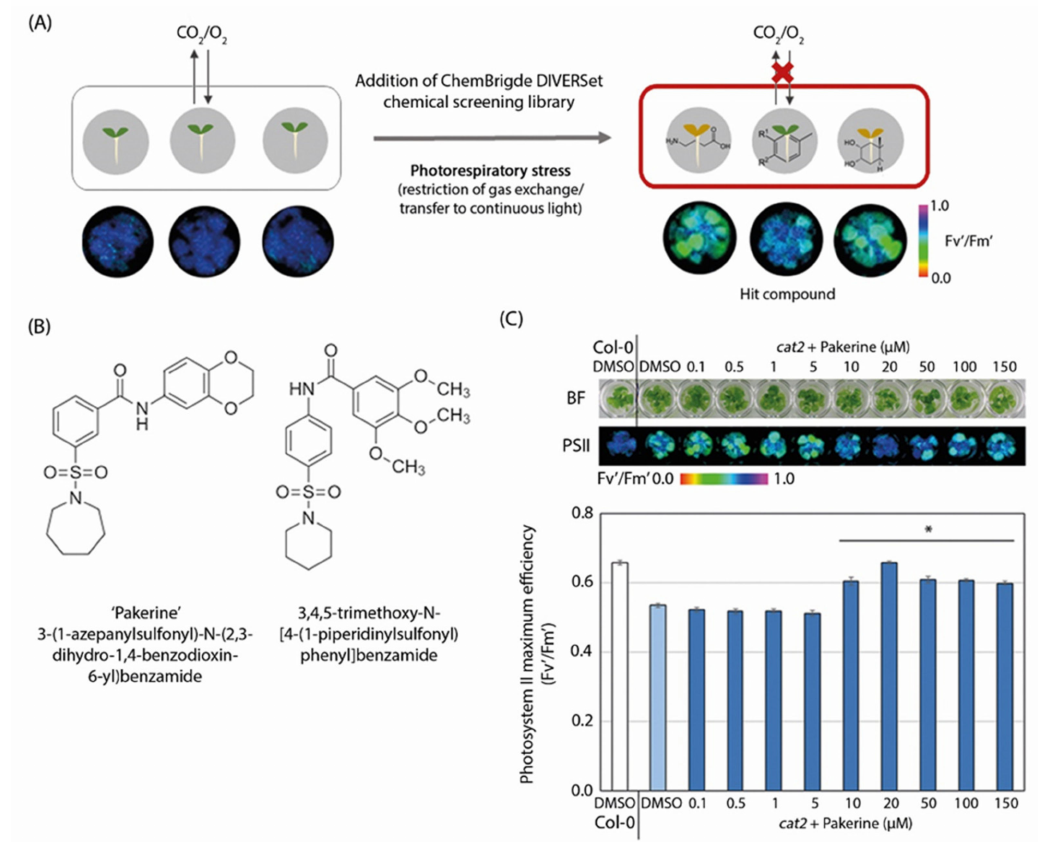
Figure 1. Strategy to identify small molecules that alleviate the photorespiratory phenotype of catalase-deficient plants together with chemical structures of two hit compounds. ( A ) Schematic depiction of the forward chemical screed used to isolate small molecules that attenuate photosystem II (PSII) maximum e ffi ciency (F v ’ / F m ’) decrease in cat2-2 mutants plants exposed to photorespiratory stress (sealing plates airtight with Parafilm and transfer to continuous light). In total, 10,000 chemicals from the DIVERSet screening library were tested in 50 µ M concentration. Shown are representative color-coded F v ’ / F m ’ images (black (0.0) to purple (1.0)) before and after chemical addition and exposure to photorespiratory stress. ( B ) Chemical structures of two of the hit compounds identified in the forward chemical screen. ( C ) E ff ect of di ff erent concentrations of pakerine on the photorespiratory phenotype of cat2-2 mutant plants. Bright-field (BF) and color-coded F v ’ / F m ’ (PSII) images (upper panel) together with quantitative F v ’ / F m ’ data (lower panel) from seven-day-old seedlings treated with pakerine and exposed to photorespiratory stress for seven days. Control plants were treated with dimethyl sulfoxide (DMSO). Data points represent means of eight biological replicates ± standard error (SE). Asterisks indicate significant di ff erences according to one-way ANOVA with least significant di ff erence (LSD) post hoc test ( p <